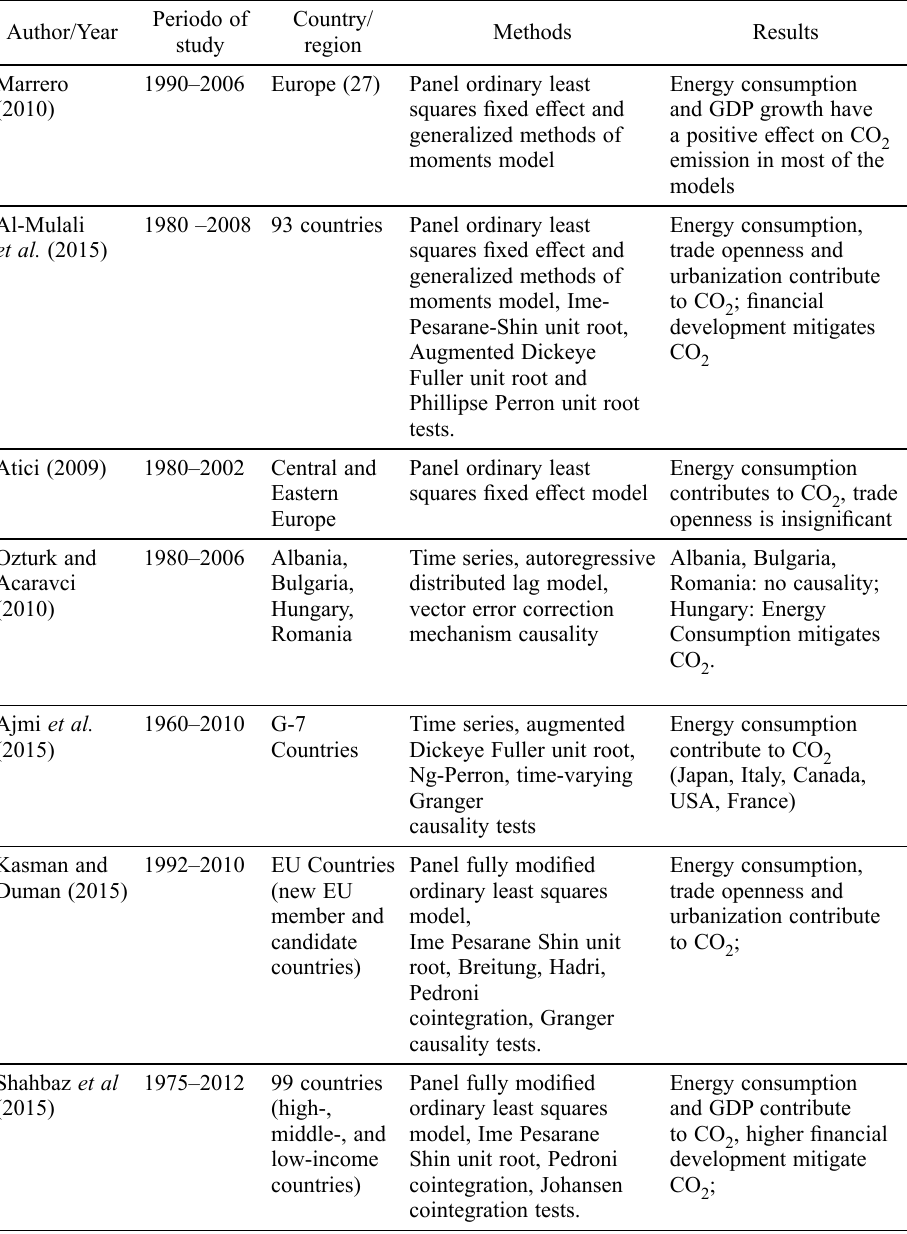
Table 1. GHG (CO ) – GDP – general energy 2